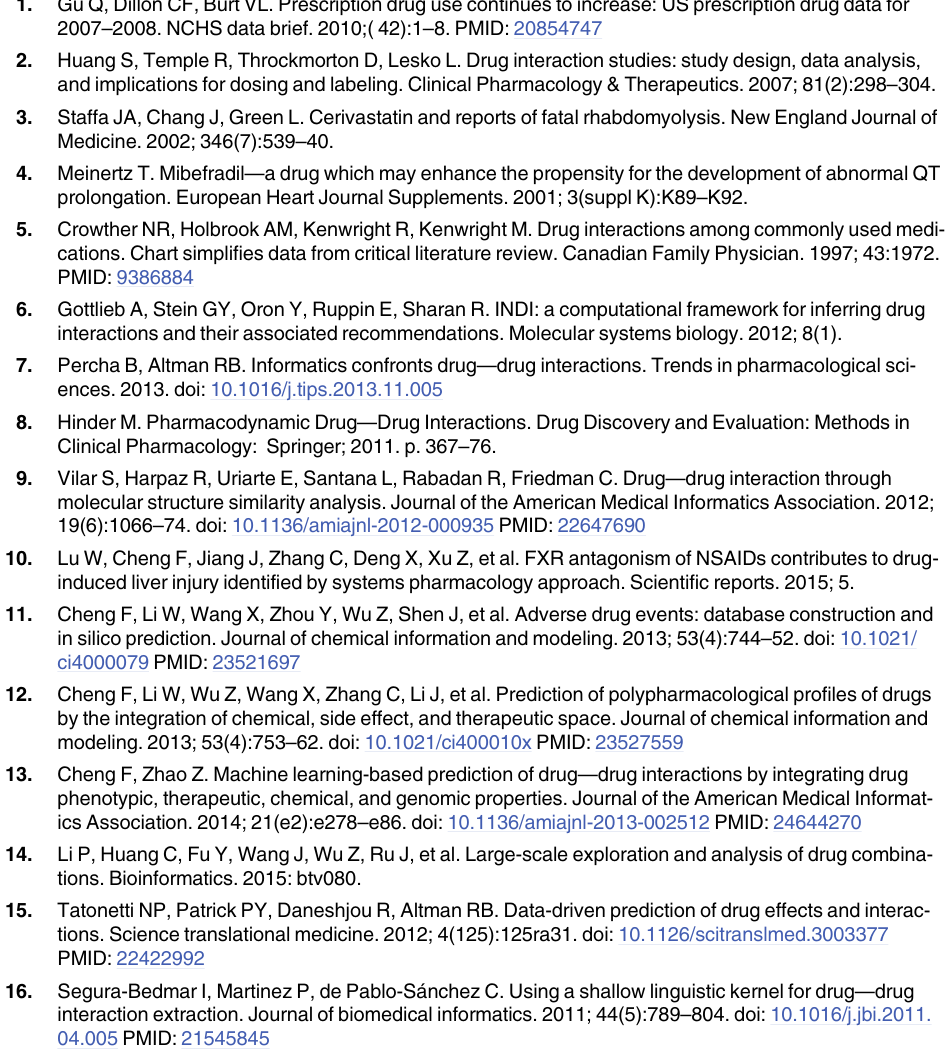
S2 Table. 306 PD DDI-associated genes of ziprasidone-quetiapine, olanzapine-quetiapine and aripiprazole-quetiapine. Three PD DDIs have same PD DDI-associated genes because ziprasidone, olanzapine, and aripiprazole have same target